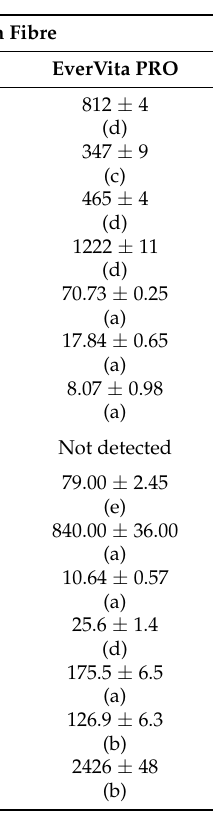
Table 2. Pasting properties and dough analysis of samples. The results show mean values ± standard deviations. Values with the same lower-case letter in a row do not differ significantly from each